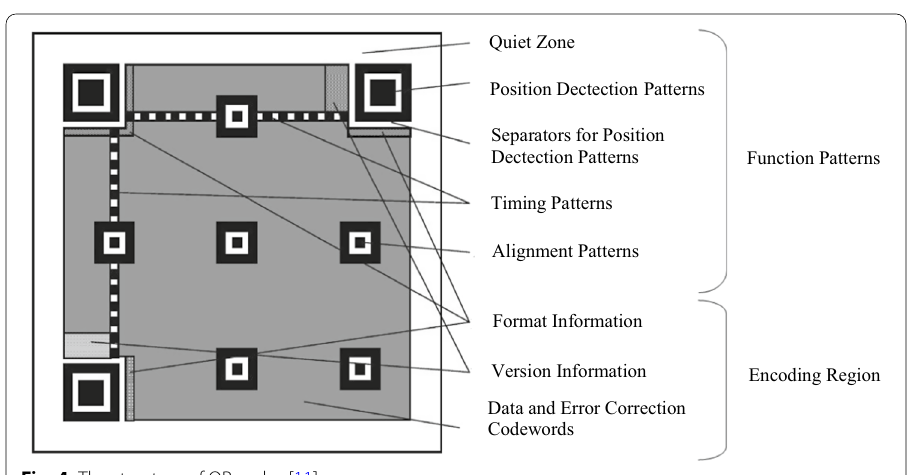
Fig. 4 The structure of QR codes